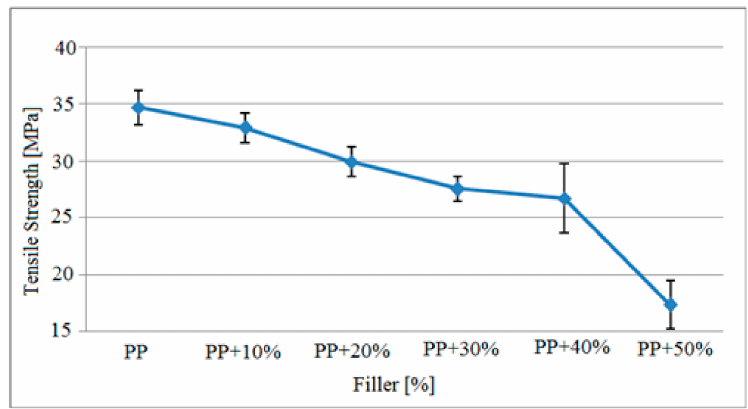
Figure 4. The variations in tensile stress of the polypropylene matrix specimens after gamma radiation based on the filler material.